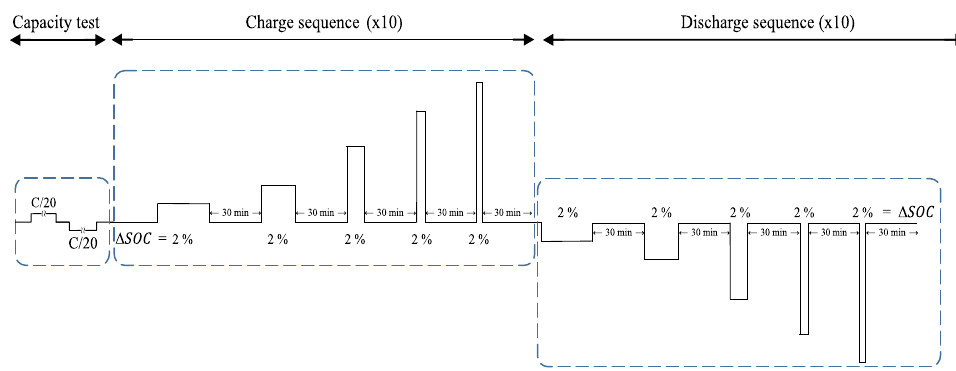
Figure 4. Implemented pulse test current profile used to obtain ECM parameters.